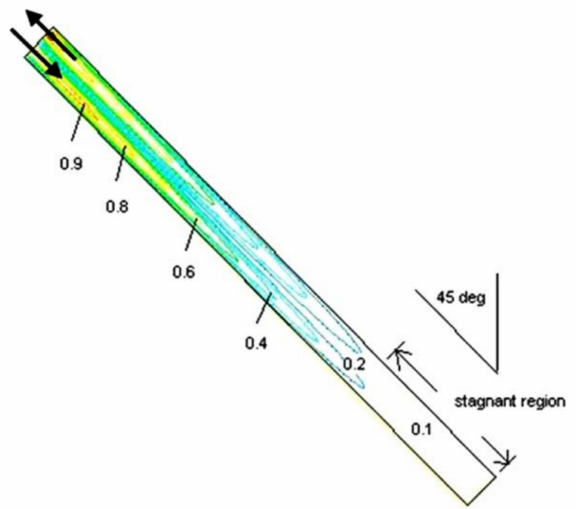
Figure 6. Velocity distribution in a single-ended tube and the presence of a stagnation region (Morrison et al., 2004).